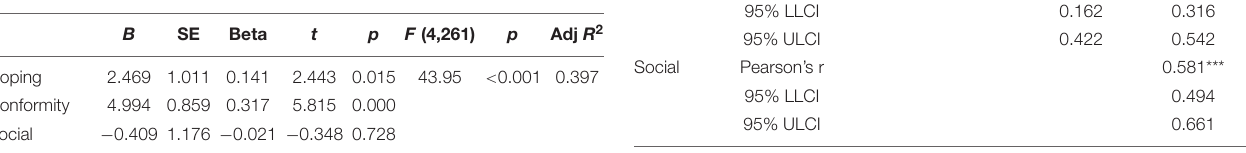
TABLE 5 | A regression model with an AUDIT score as an explained variable and motives to drink as predictors (four-factor model).